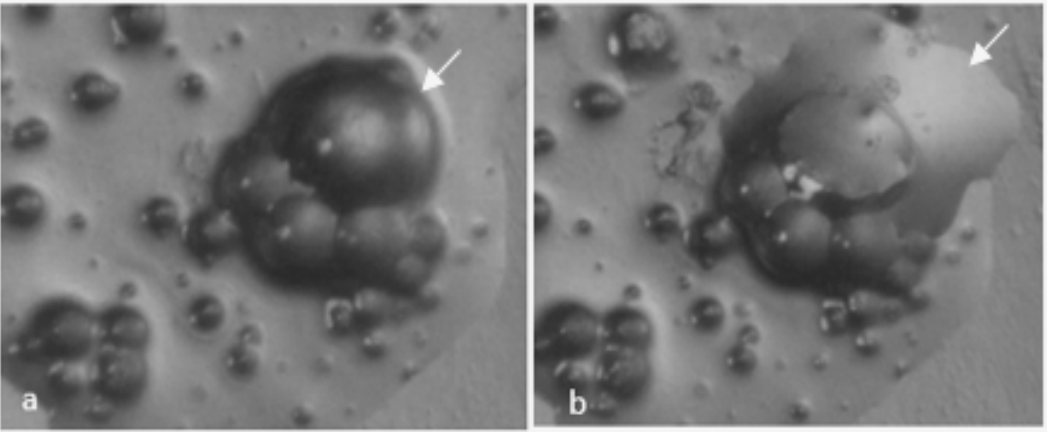
Figure 5. Optical microscopy images: ( a ) I MCs before tearing of the shell by the point of a needle; and ( b ) the same image after breaking the shell, exhibiting release of the core content (IPDI).